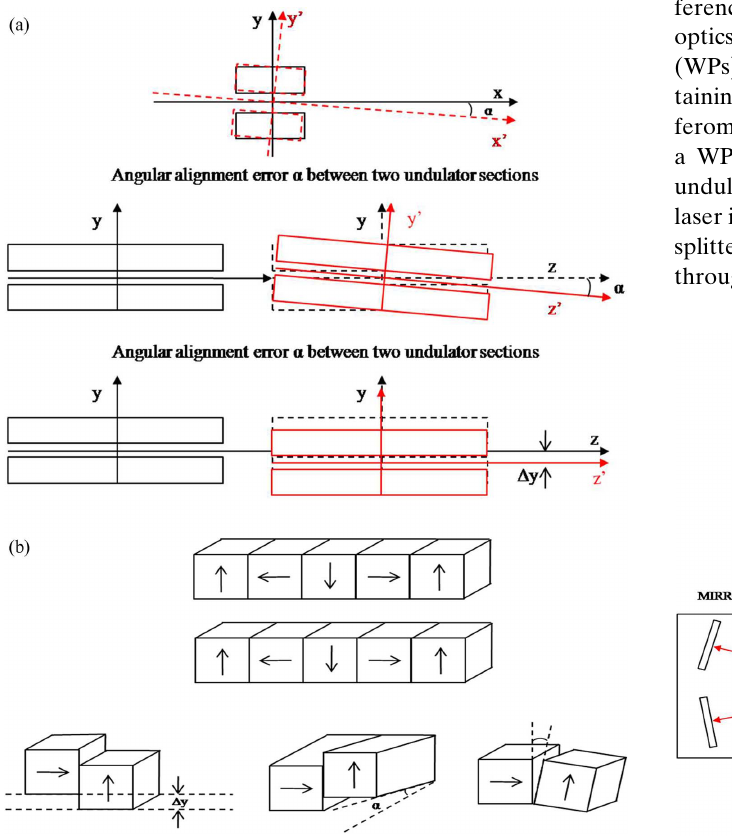
Figure 2 Schematic of the laser interferometer.